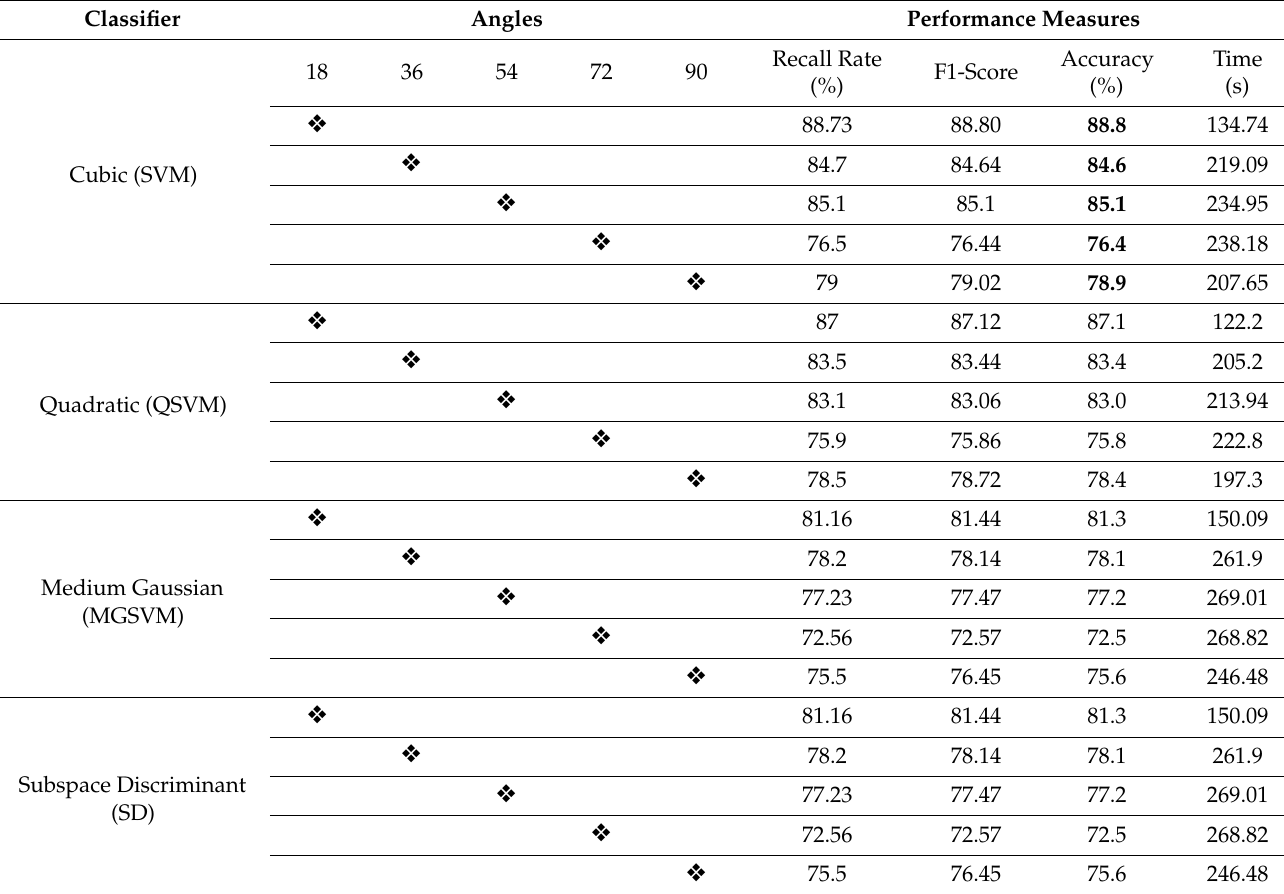
Table 3. Gait recognition results using modified NasNet-Mobile on selected angles of the non-augmented CASIA B da- taset.